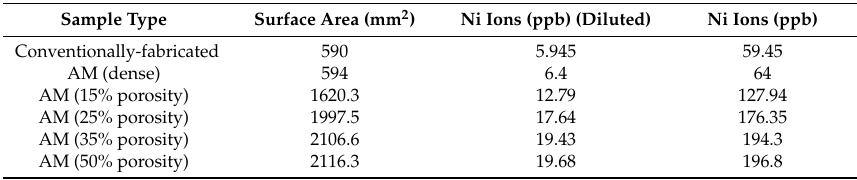
Table 3. The surface area and Ni ion release measurements for the conventionally fabricated and additively manufactured NiTi samples (bulk and porous).